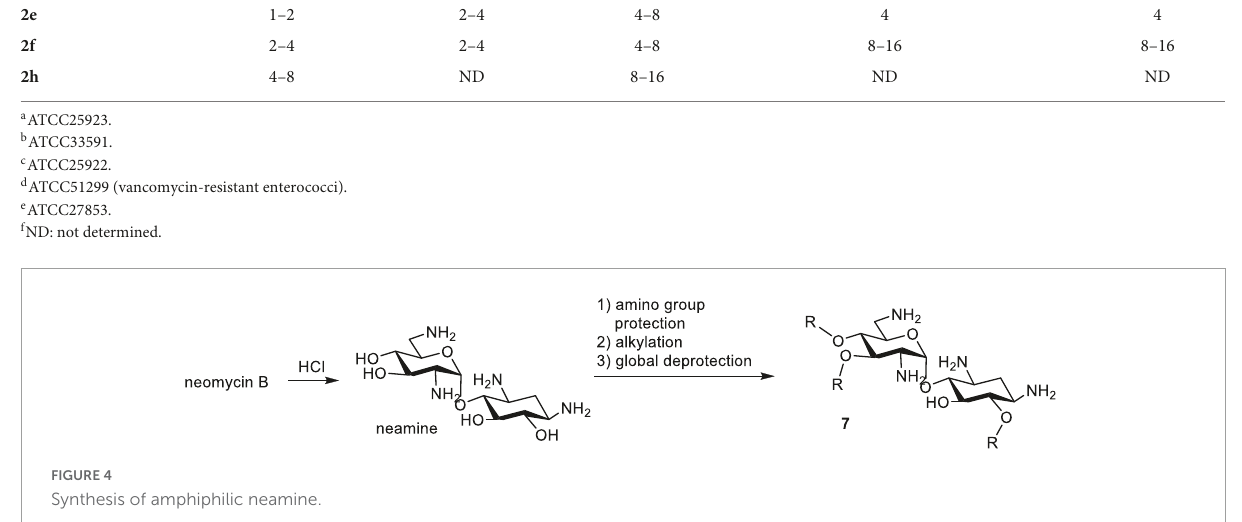
FIGURE4 Synthesis of amphiphilic